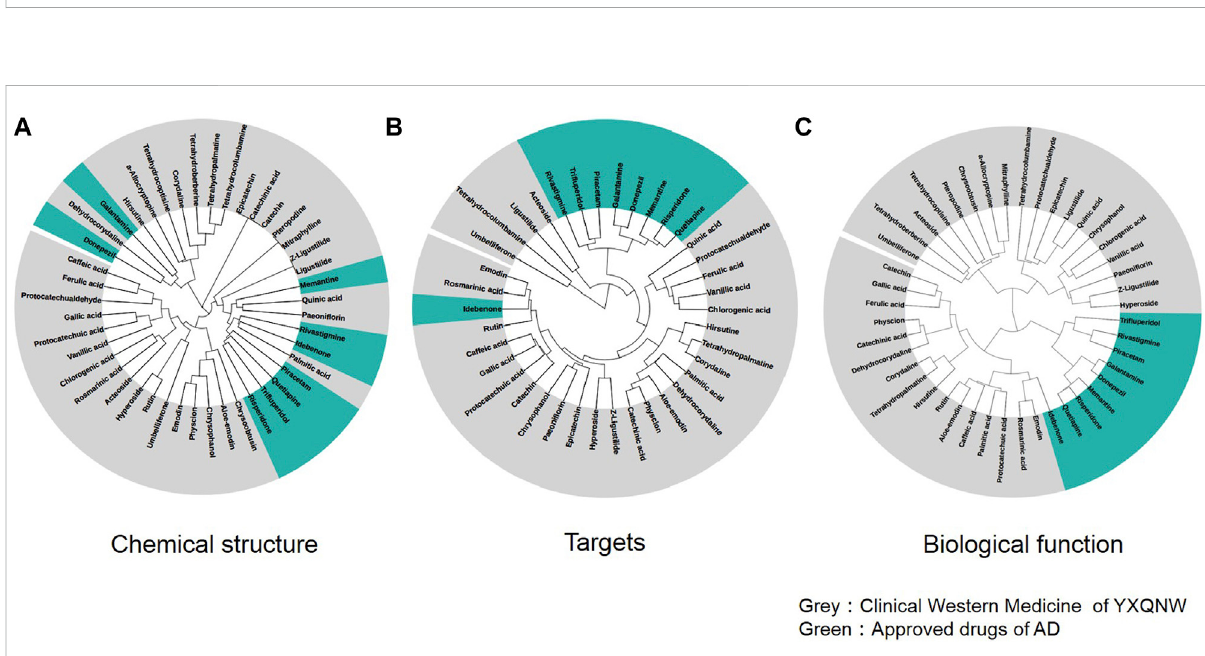
FIGURE 2 Unsupervised hierarchical clustering of YXQNW compounds and approved drugs based on the similarity of the chemical structure (A) , drug comprehensive targets (B) , and biological functions (C)